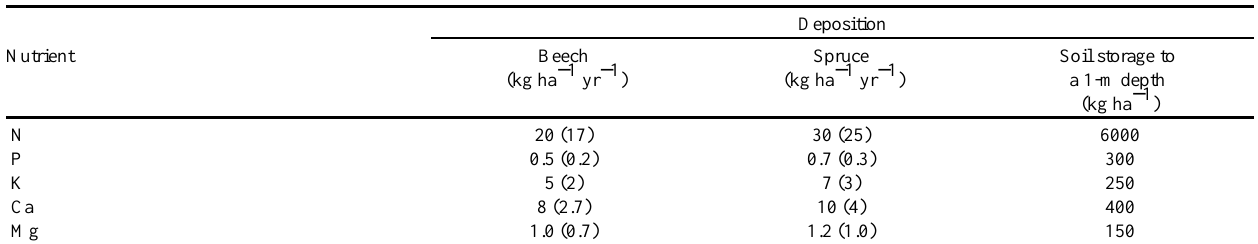
Table 2 . Deposition (open field) and storage of nutrients in the top 100 cm of the soil profile. †